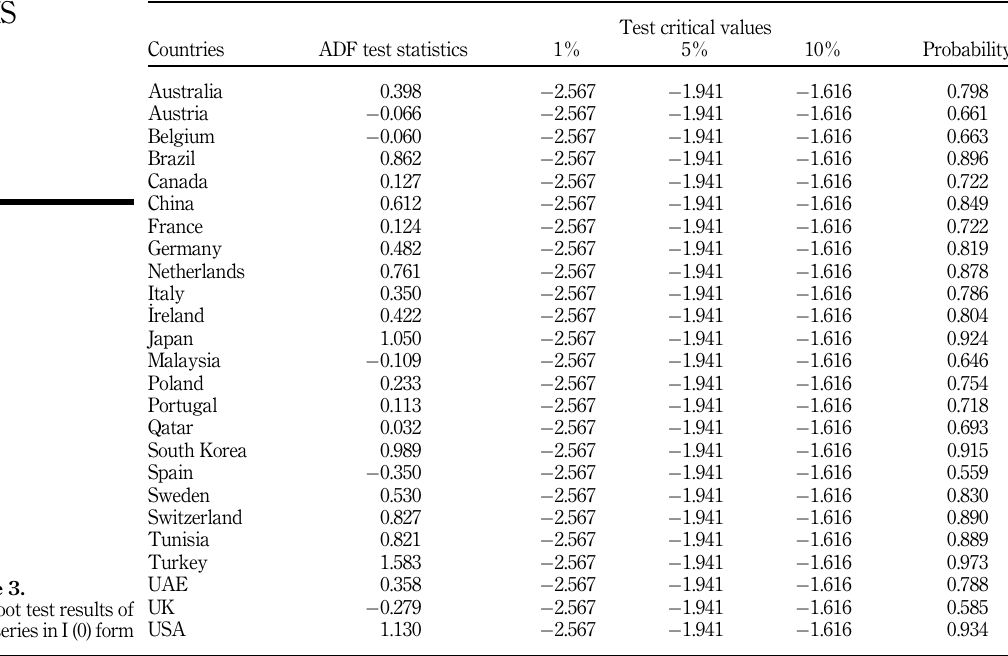
Table 3. Unit root test results of price series in I (0)